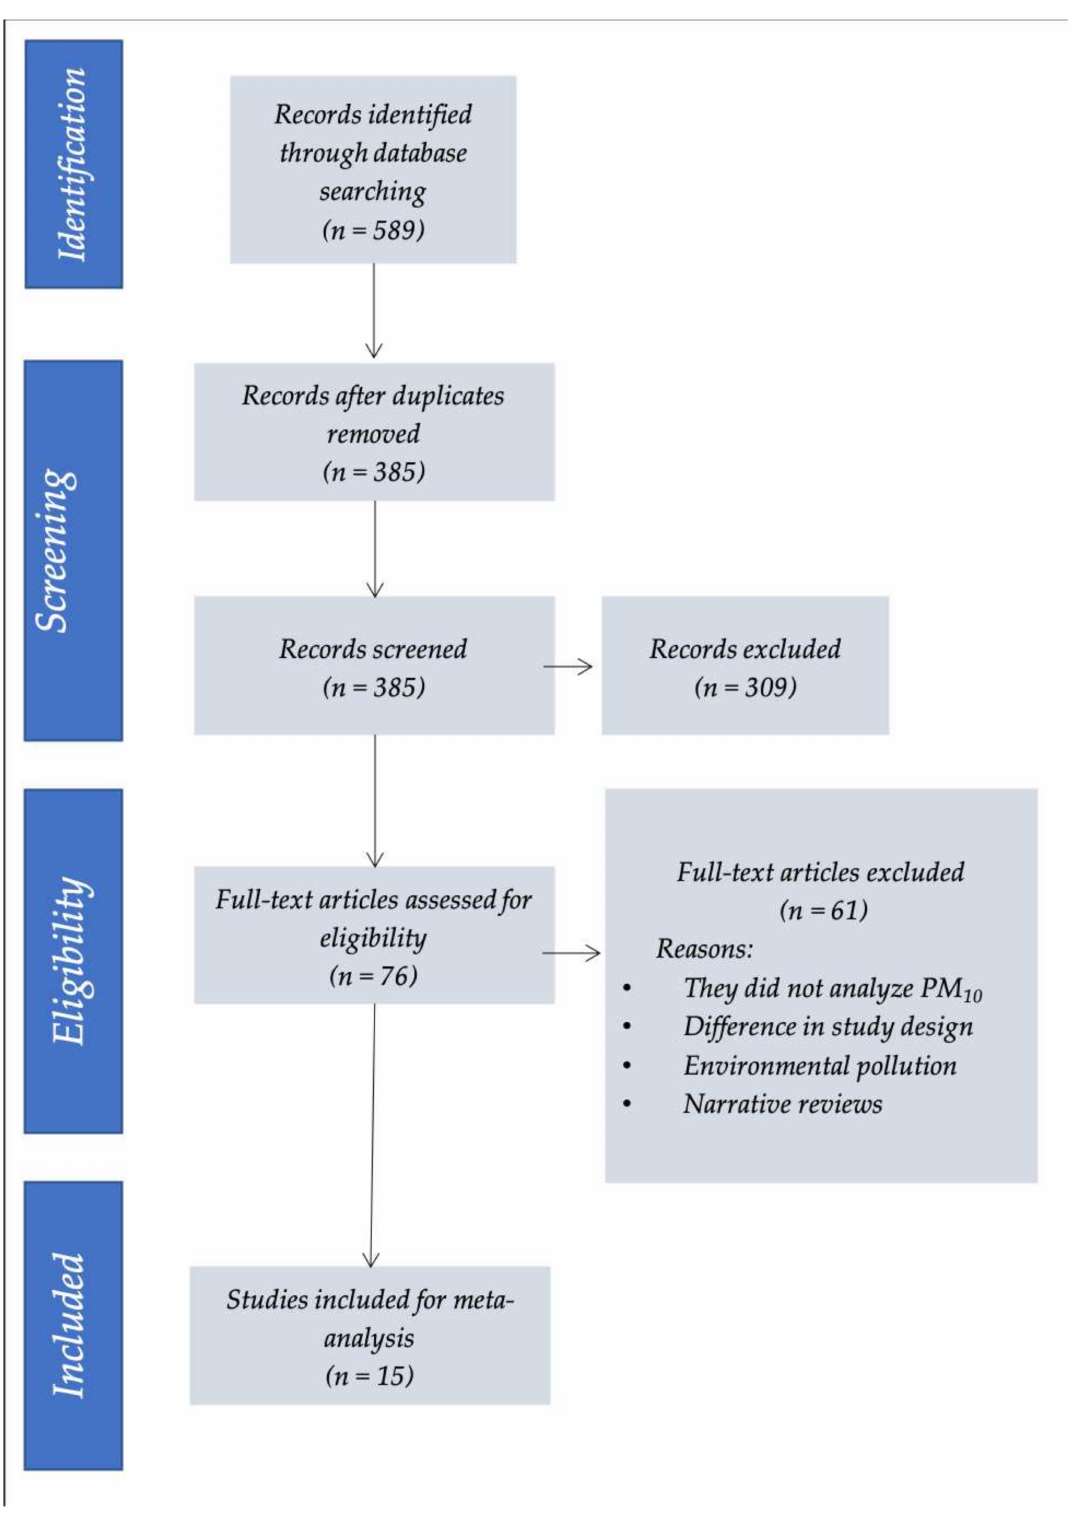
Figure 2. Selection of studies (PRISMA